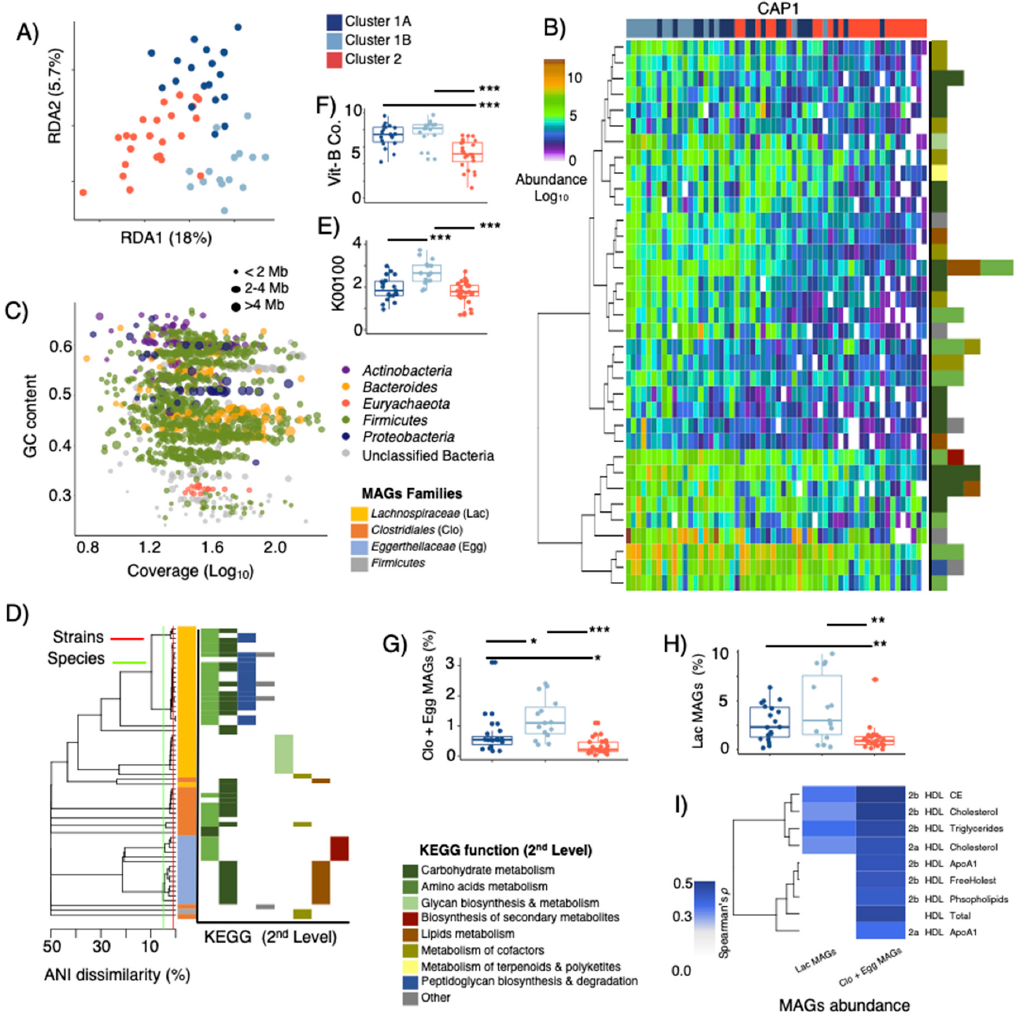
Figure 5. ( A ) RDA displaying discrimination of LPD clusters based on selected KOs obtained from shotgun metagenome and assembly ( p = 0.001, explained variance = 23.7%). ( B ) Overview of